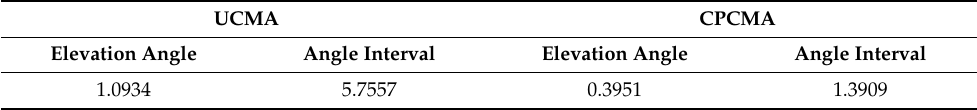
Table 14. RMSE in ball pass location inner race (BPLI) by both arrays at 290 rpm.